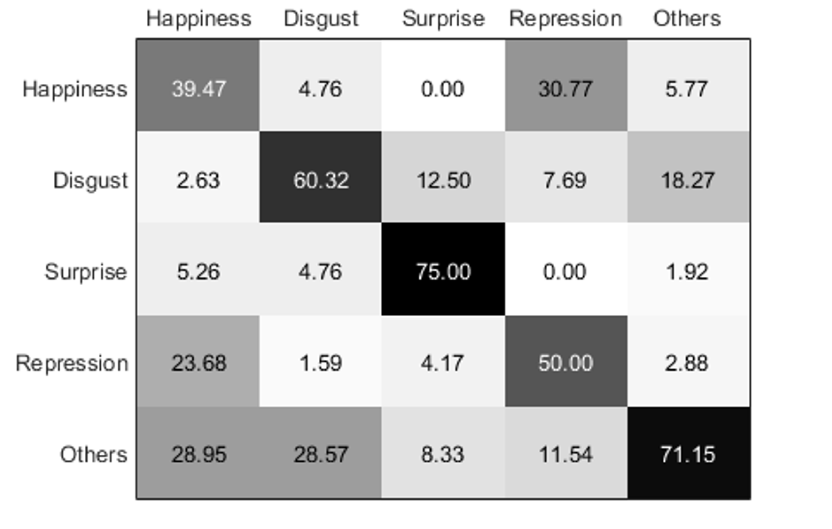
Figure 3. Confusion matrix of the original CASME II classes using the LBP-TOP feature, using SMO as a classifier.